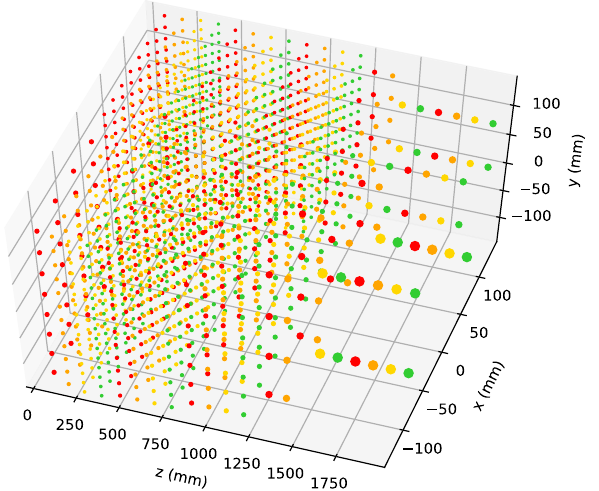
Fig. 2 Calorimeter geometry. The markers indicate the centre of the sensors, their size the sensor size. Layers are colour-coded for better visualisation Table 1 Number of cells in the finely segmented quadrant and the rest of the layer, for the benchmark calorimeter geometry described in